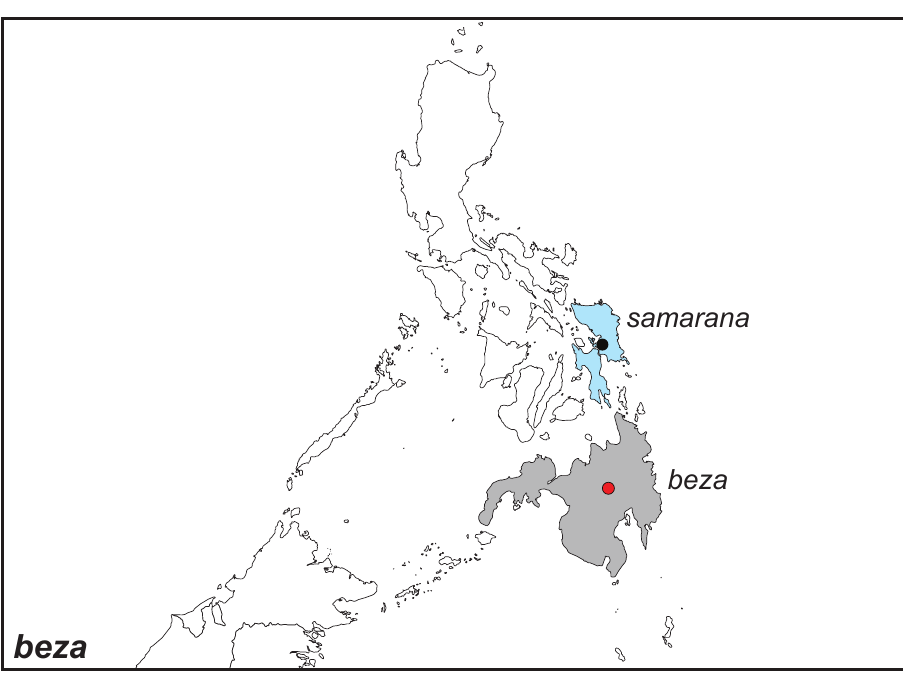
Figure 62. Distribution map of Elymnias beza